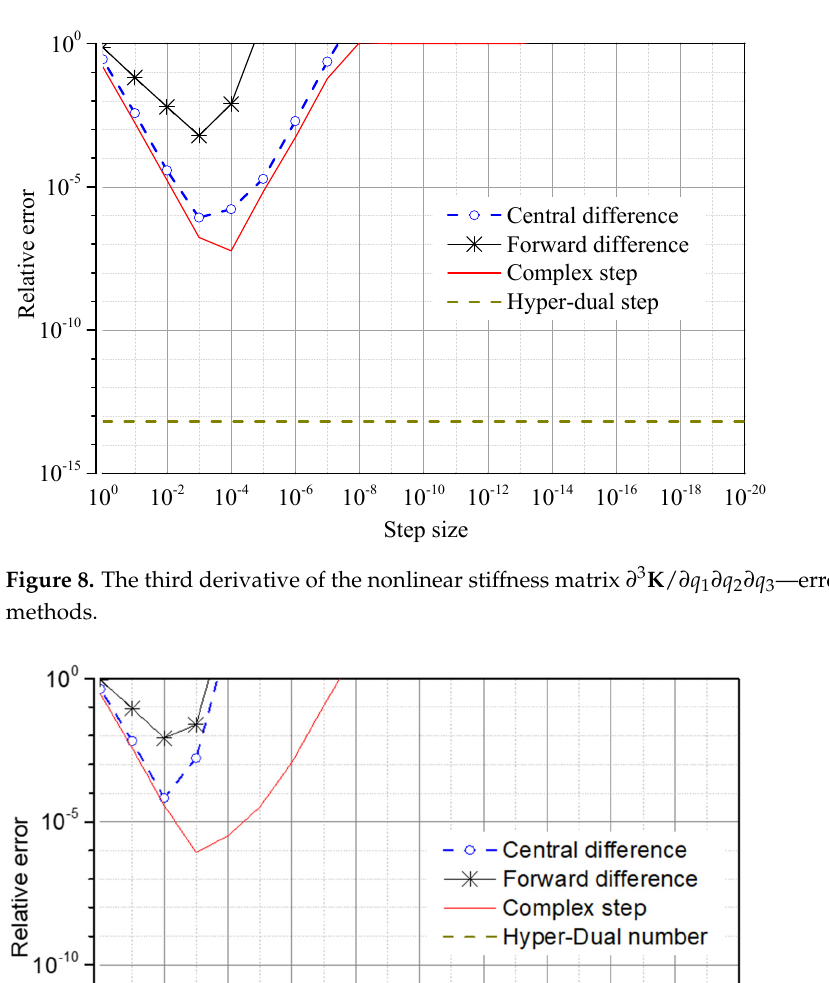
Figure 7. The second derivative of the nonlinear sti ff ness matrix ical methods.